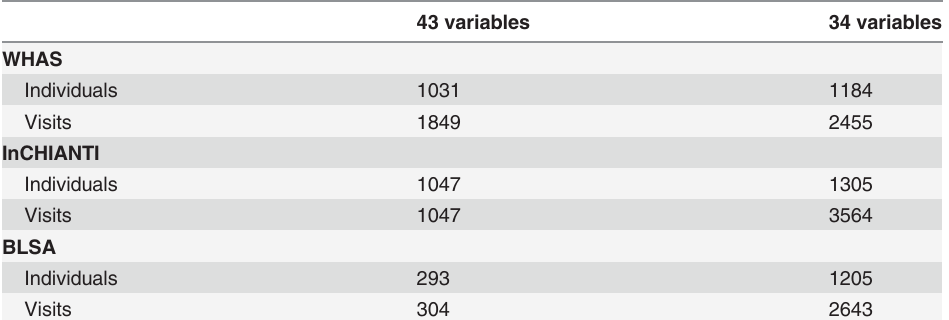
Table 2. Sample sizes for complete observations with the two variable subsets in the three data